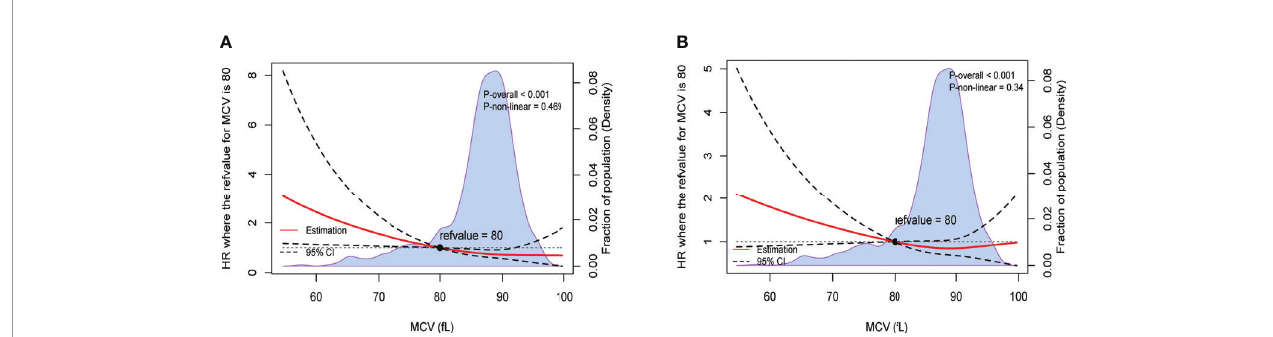
FIGURE 1 | Preoperative MCV and the corresponding hazard ratios on a continuous scale, including (A) . OS after adjusting for other prognostic factors; (B) . RFS after adjusting for other prognostic factors. Analyses were carried out using restricted cubic splines, with hazard ratios and 95% con fi dence intervals from multivariate Cox proportional hazards regression. The pretreatment MCV of 80fL was chosen as the reference. The purple area indicated the distribution of concentration of the pretreatment MCV.